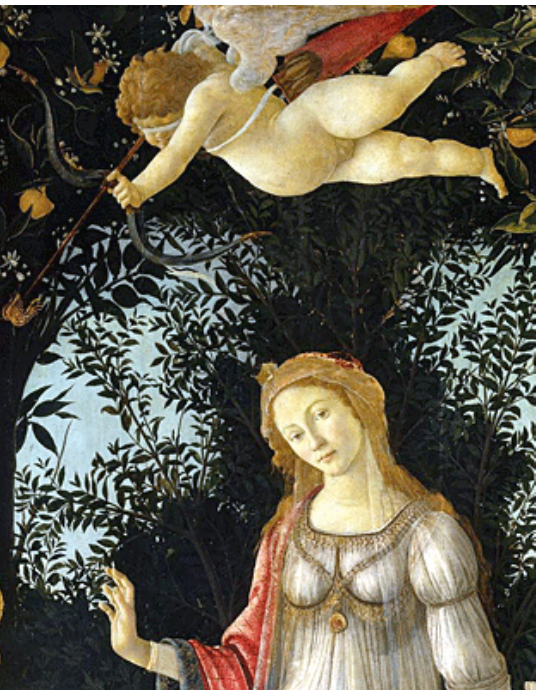
Figure 2. Sandro Botticelli, details of Primavera ; Allegory of Spring, c. 1478, Galleria degli Uffizi. Image and original data provided by SCALA, Florence/ART RESOURCE, N.Y.; artres.com; scalarchives.com | (c) 2006. The detail above shows Venus, or rather Isis, with her characteristic pendant, and the idea of passionate, blind love embodied by the Cupid’s arrow. https:// artstor.files.wordpress.com/2013/03/